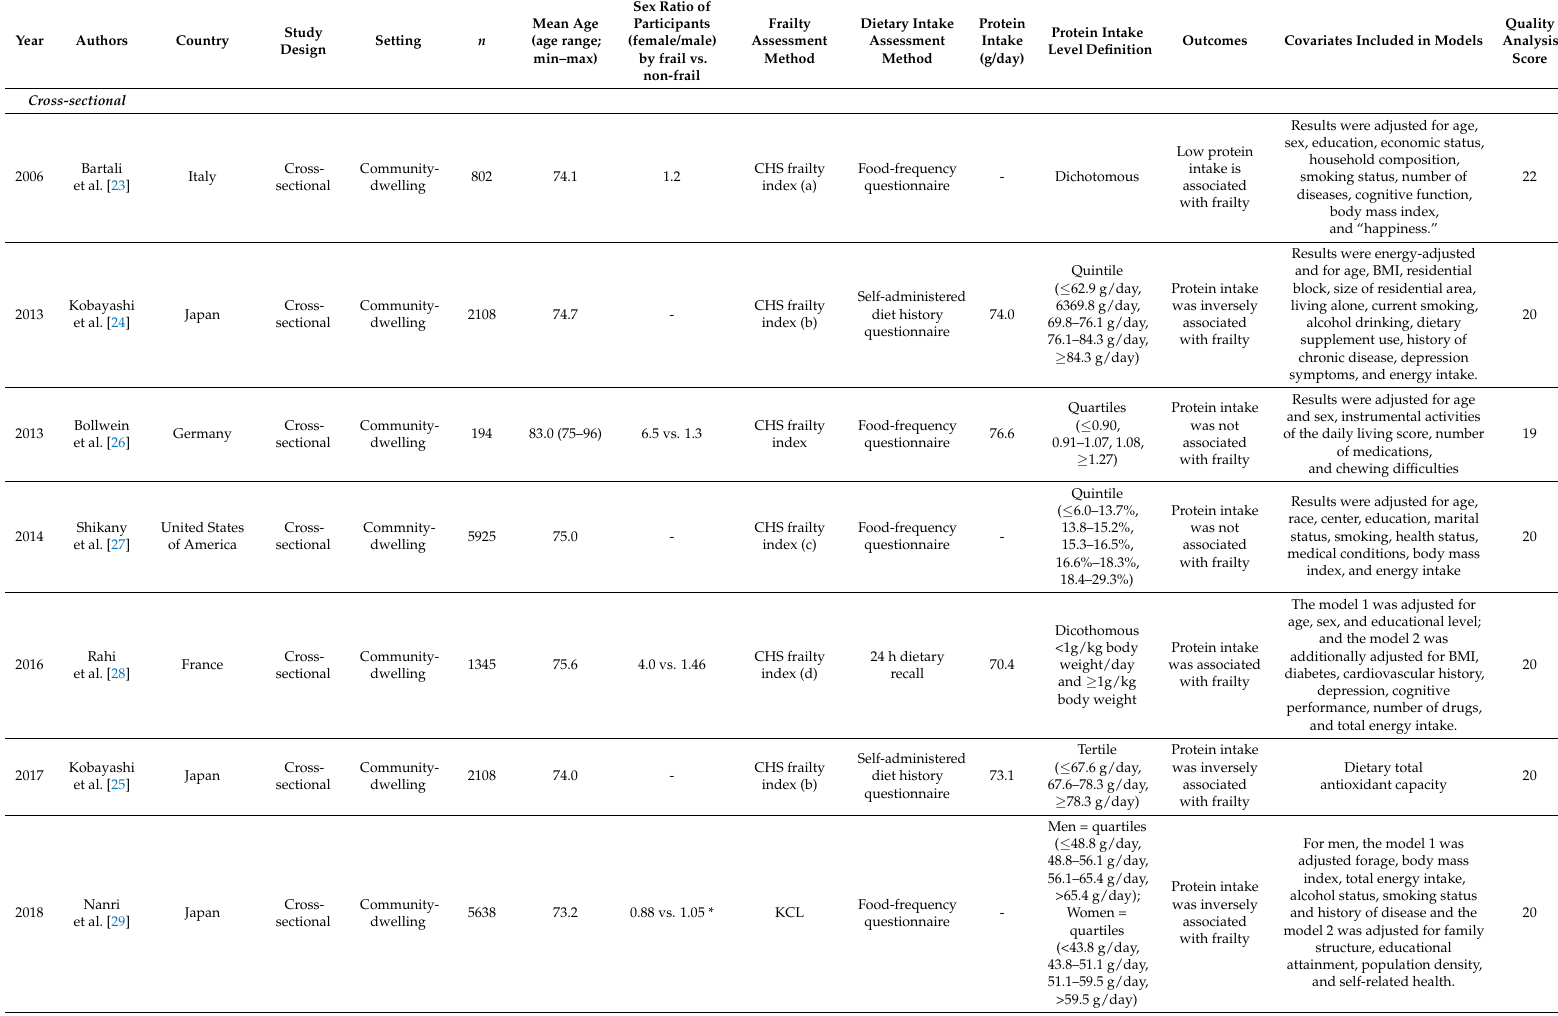
Table 1. General description of the included